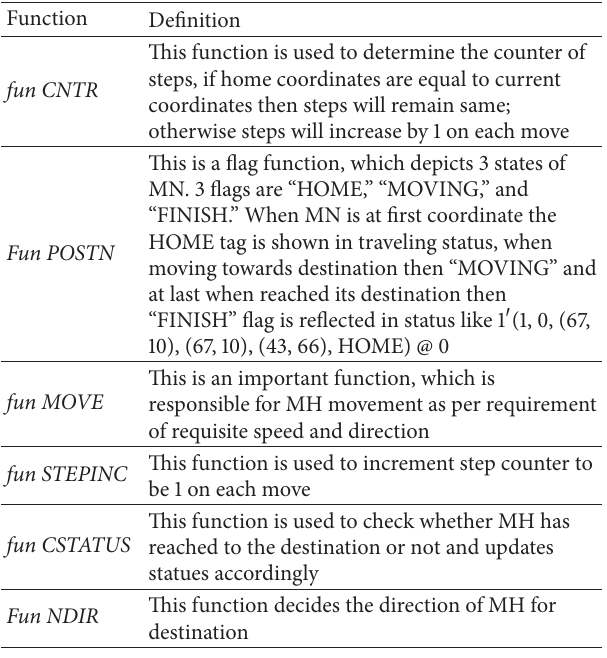
Table 2: The function. Table 3: Movement pattern of 4 NODES after 1200 steps